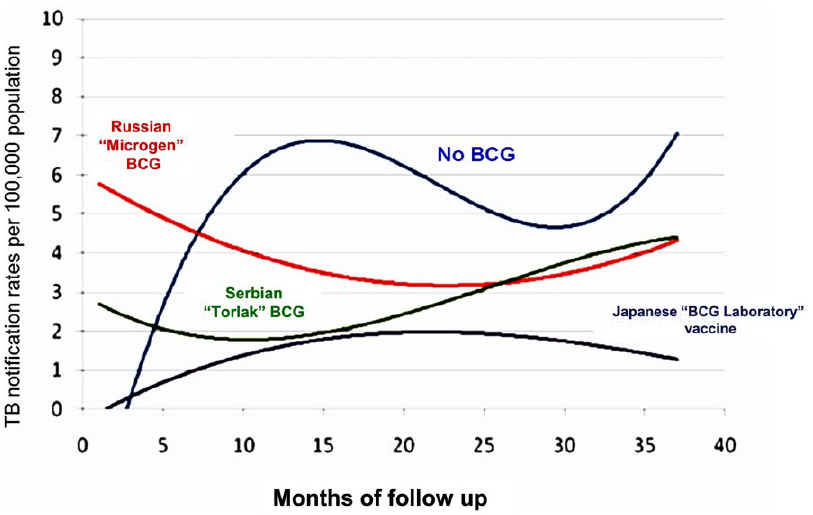
Figure 2. Moving average (2-month) TB notification rate of different birth cohorts born in September–March, by type of BCG administered, Kazakhstan, 2002–2008.